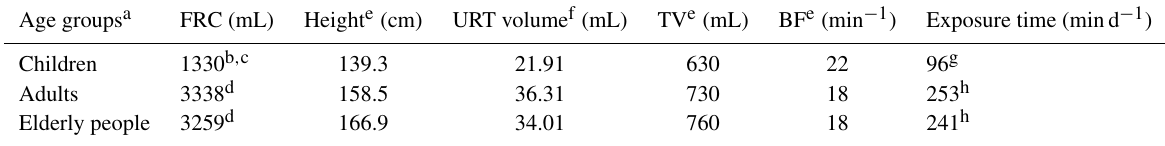
Table 1. Physiological and breathing parameters for three age